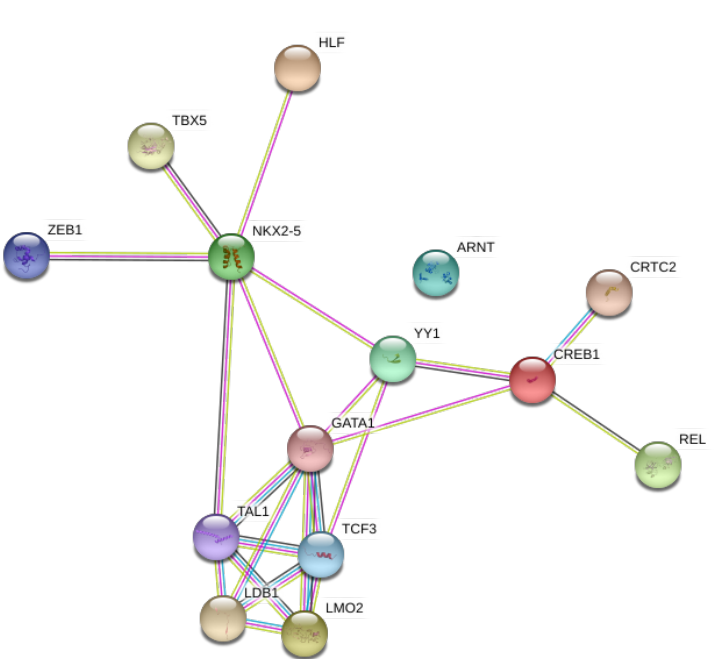
Figure 3. Network analysis of predicted transcription factors. ZEB1 is an alternative name for the transcription factor AREB6.